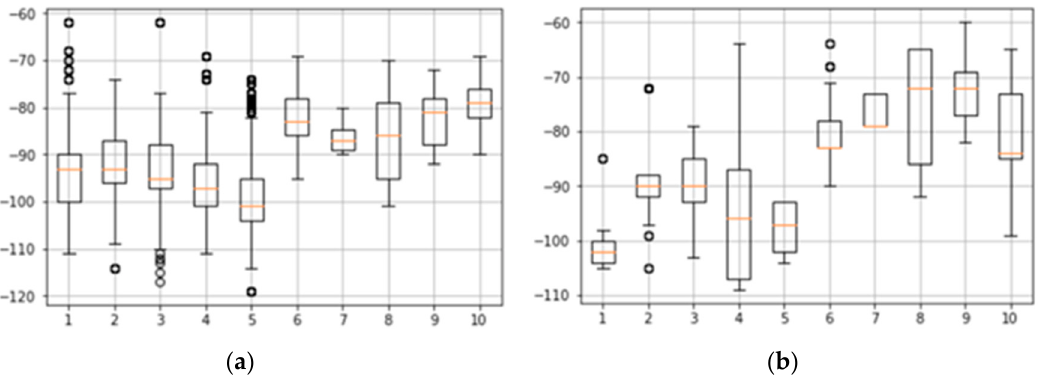
Figure 10. Box plots of signal strength per grid: ( a ) SKTelecom and ( b ) KT.